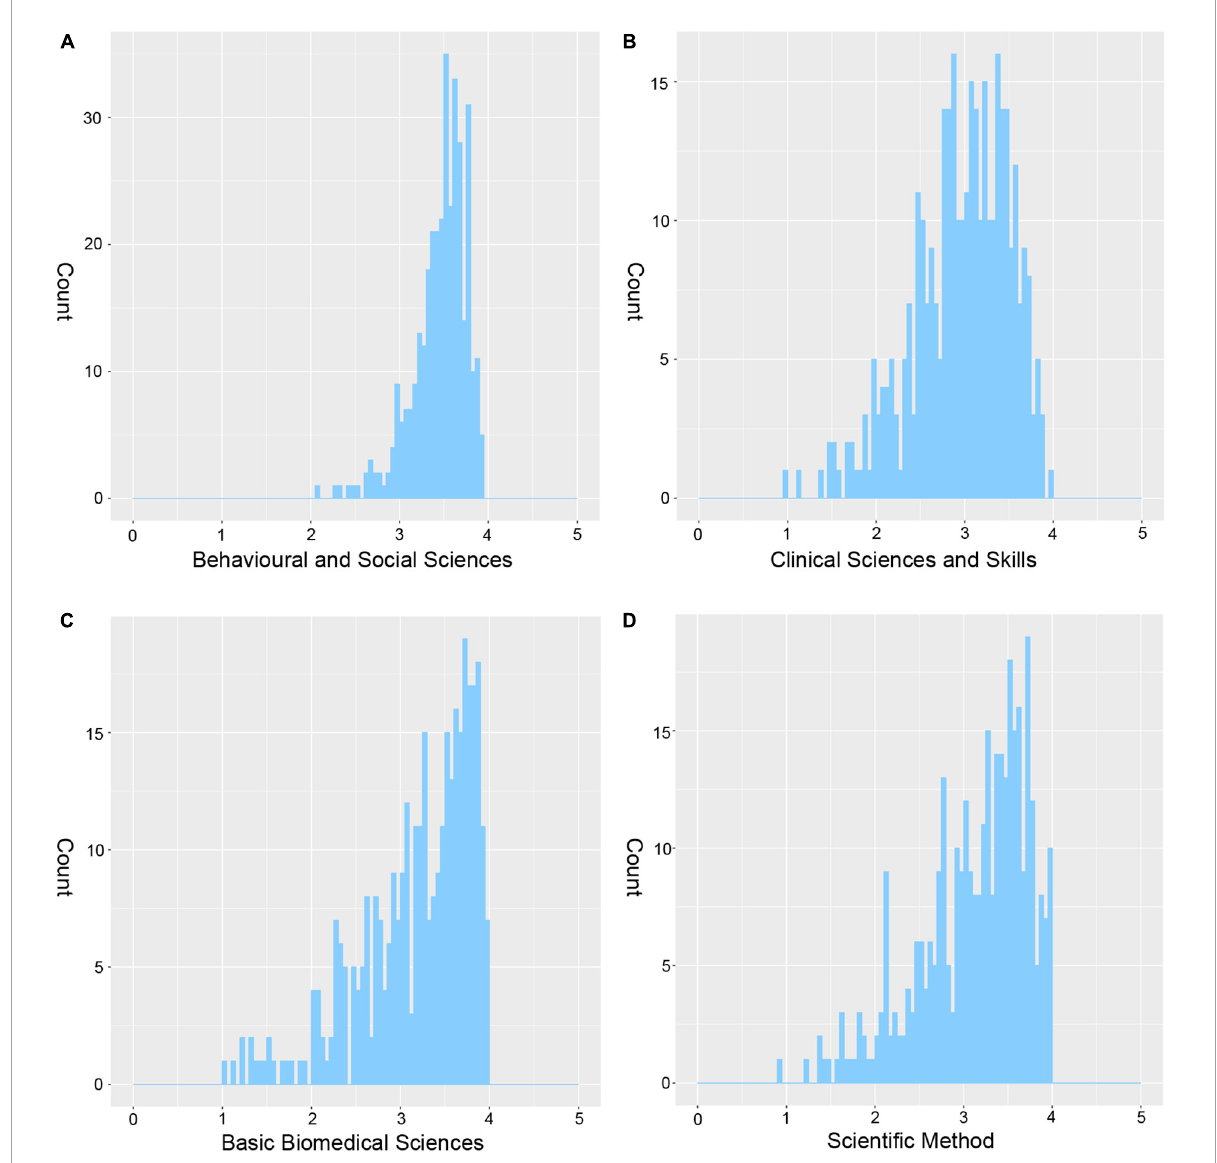
FIGURE2 The distribution of grade point average in each type of academic achievements. (A–D) The distribution of GPA scores in behavioral and social sciences, clinical sciences and skills, basic biomedical sciences, and scientific method, respectively. The x -axis shows the GPA scores and the y -axis shows the number of subjects.